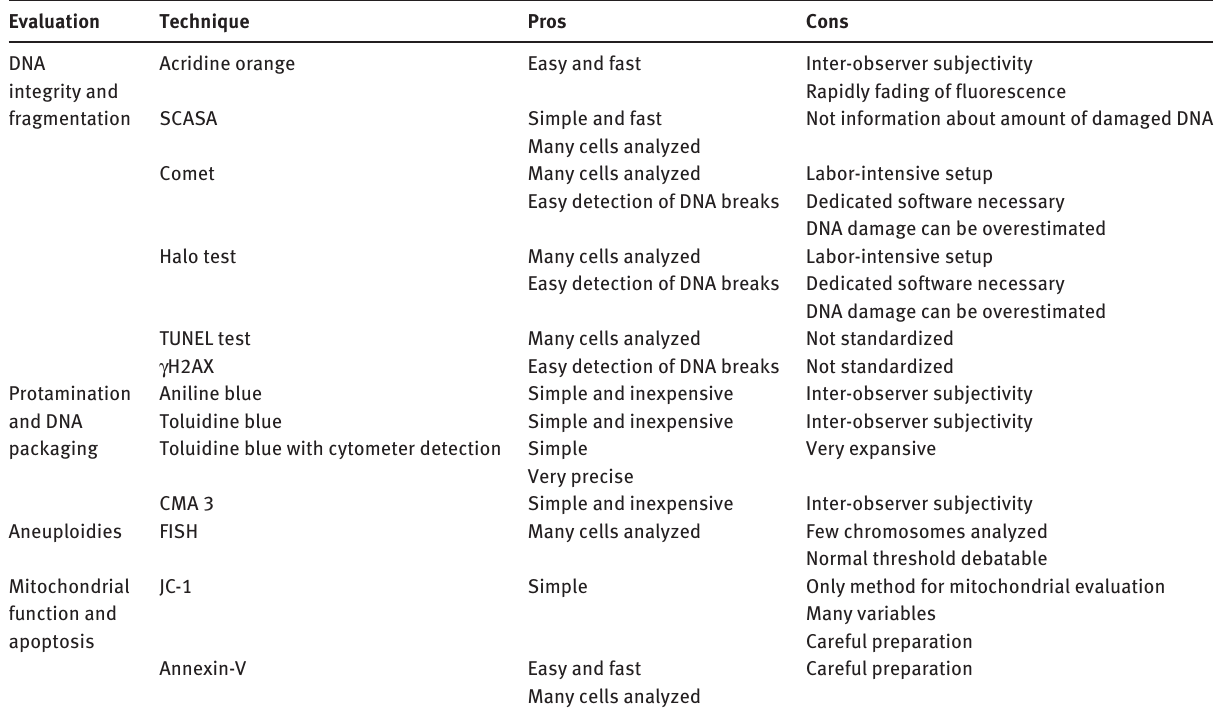
Table 1 Main molecular techniques currently applied in male infertility